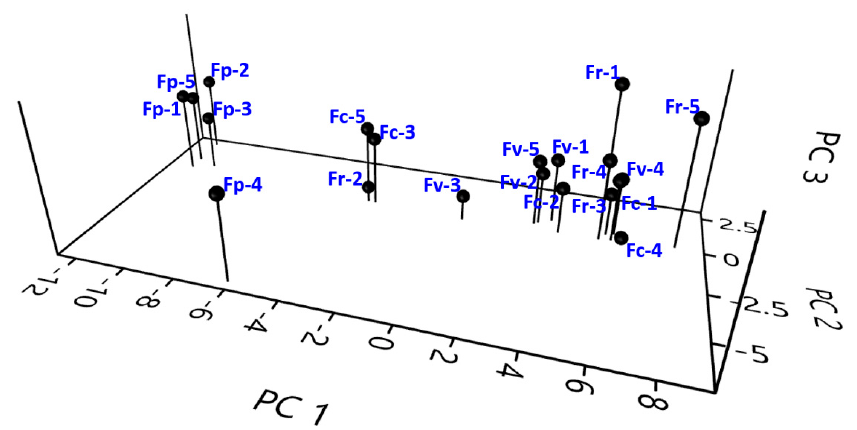
Figure 6. 3D PCA analysis of the studied Festuca specimens.